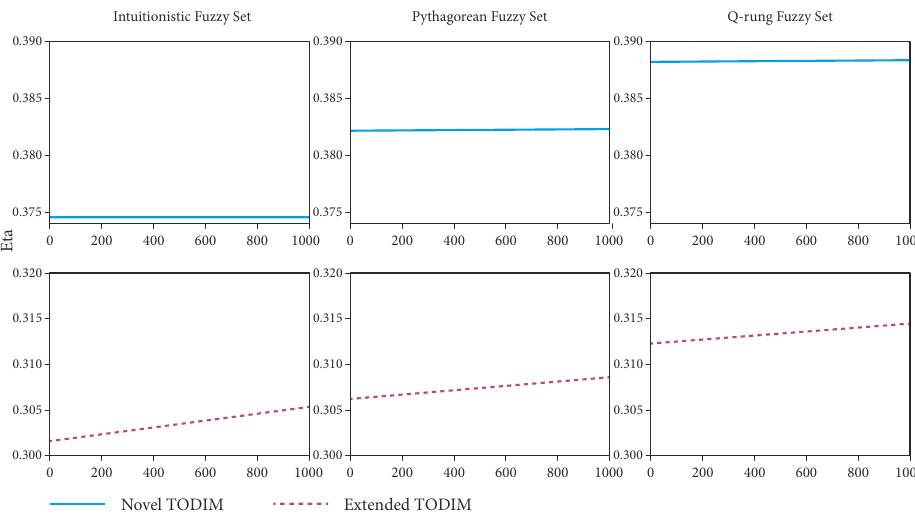
Figure 2. The sensitivity analysis results of A 4 (1.25 < l ≤